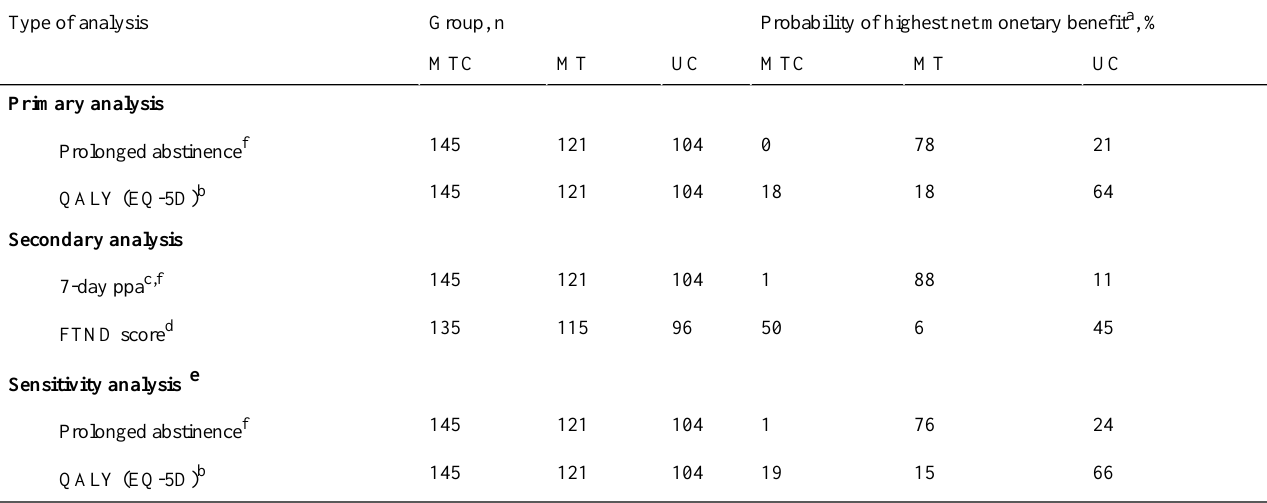
Table 5. Results from cost-effectiveness and cost-utility analyses based on 1000 bootstrap replications.